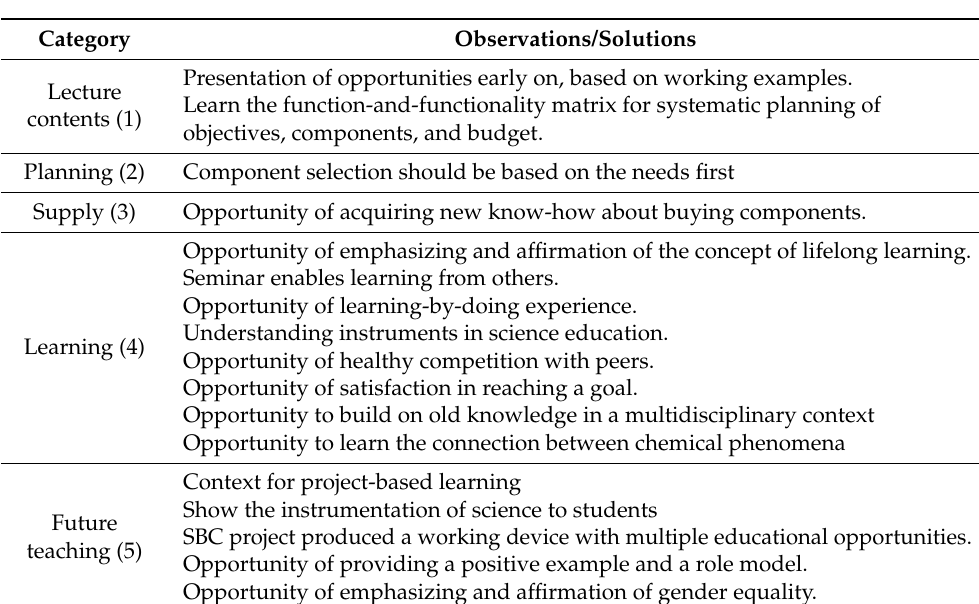
Table 2. Categorized observations associated with the opportunities of SBC for STEM education